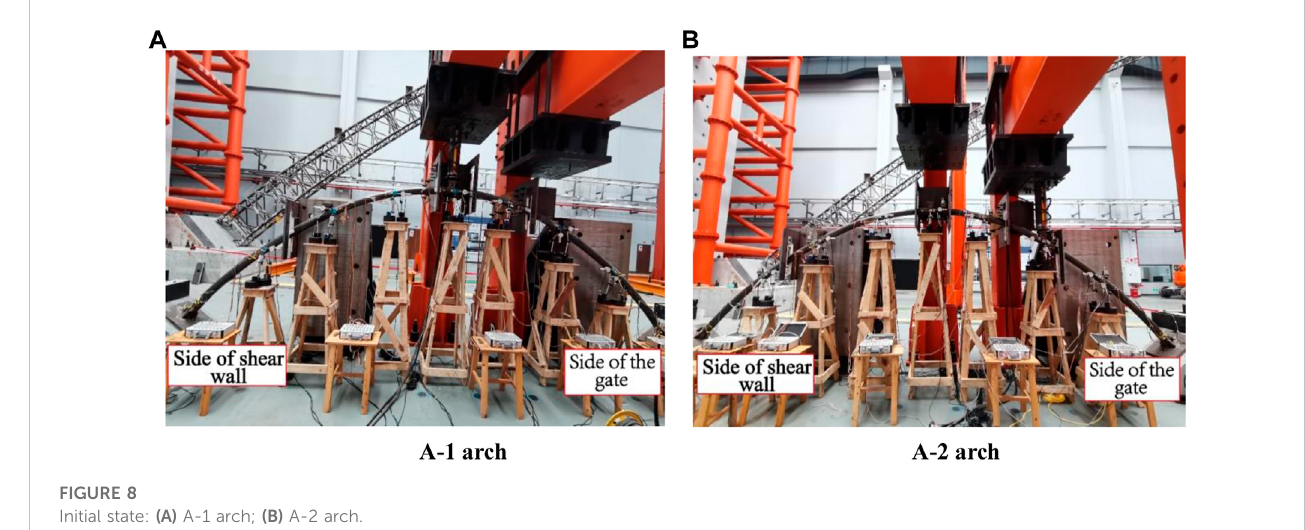
FIGURE 8 Initial state: (A) A-1 arch; (B) A-2 arch.